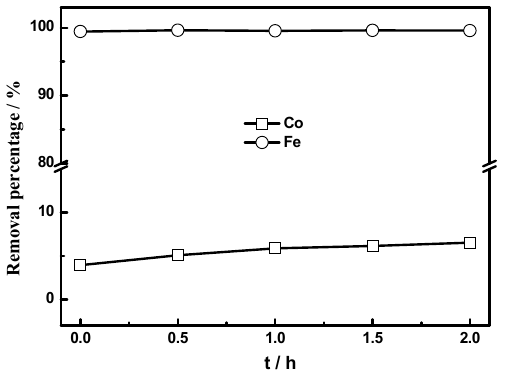
Figure 8. Effect of soaking time on the removal rate of iron and cobalt (temperature = 85 °C, equilibrium pH = 3.5).